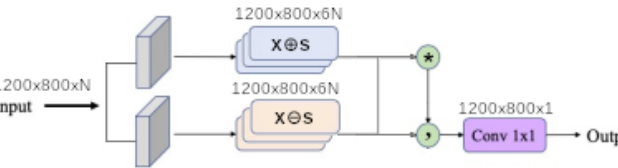
Figure 7. Dense-morphological model.